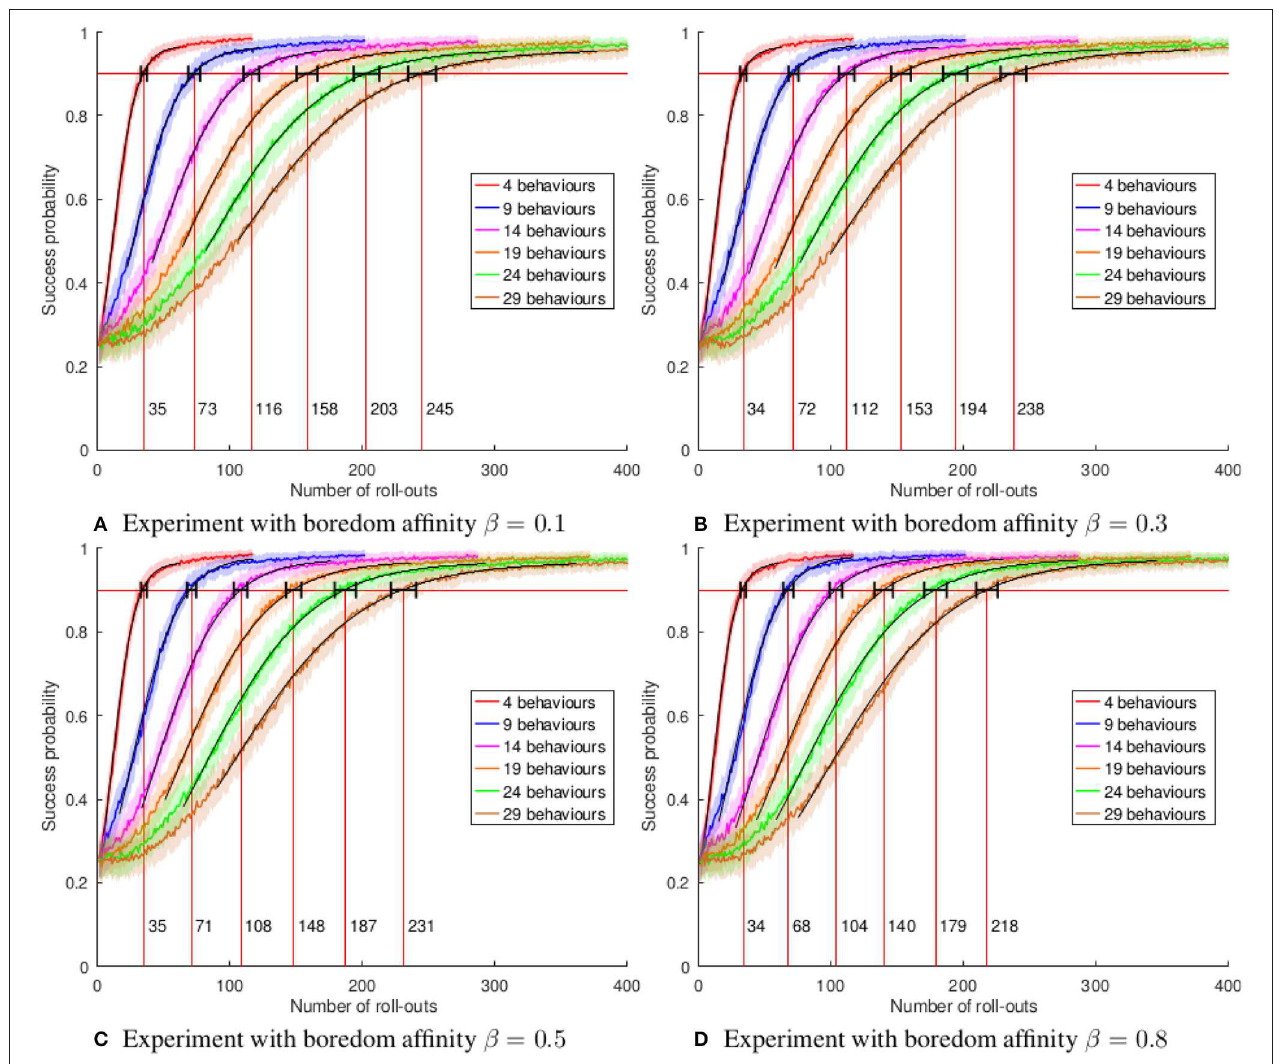
FIGURE 8 | Evolution of the simulated success rates over the number of rollouts for different numbers of preparatory behaviors with different values for the boredom affinity β parameter. For each curve from left to right, five behaviors are added. The red horizontal lines denote an average success rate of 90%. The selected parameter values were β ∈ { 0.1,0.3,0.5,0.8,1.0 } . The graph for β = 1.0 is shown in Figure 7B . Increase of affinity yields a significant increase of the learning speed proportional to β . (A) Experiment with boredom affinity β = 0.1. (B) Experiment with boredom affinity β = 0.3. (C) Experiment with boredom affinity β = 0.5. (D) Experiment with boredom affinity β =